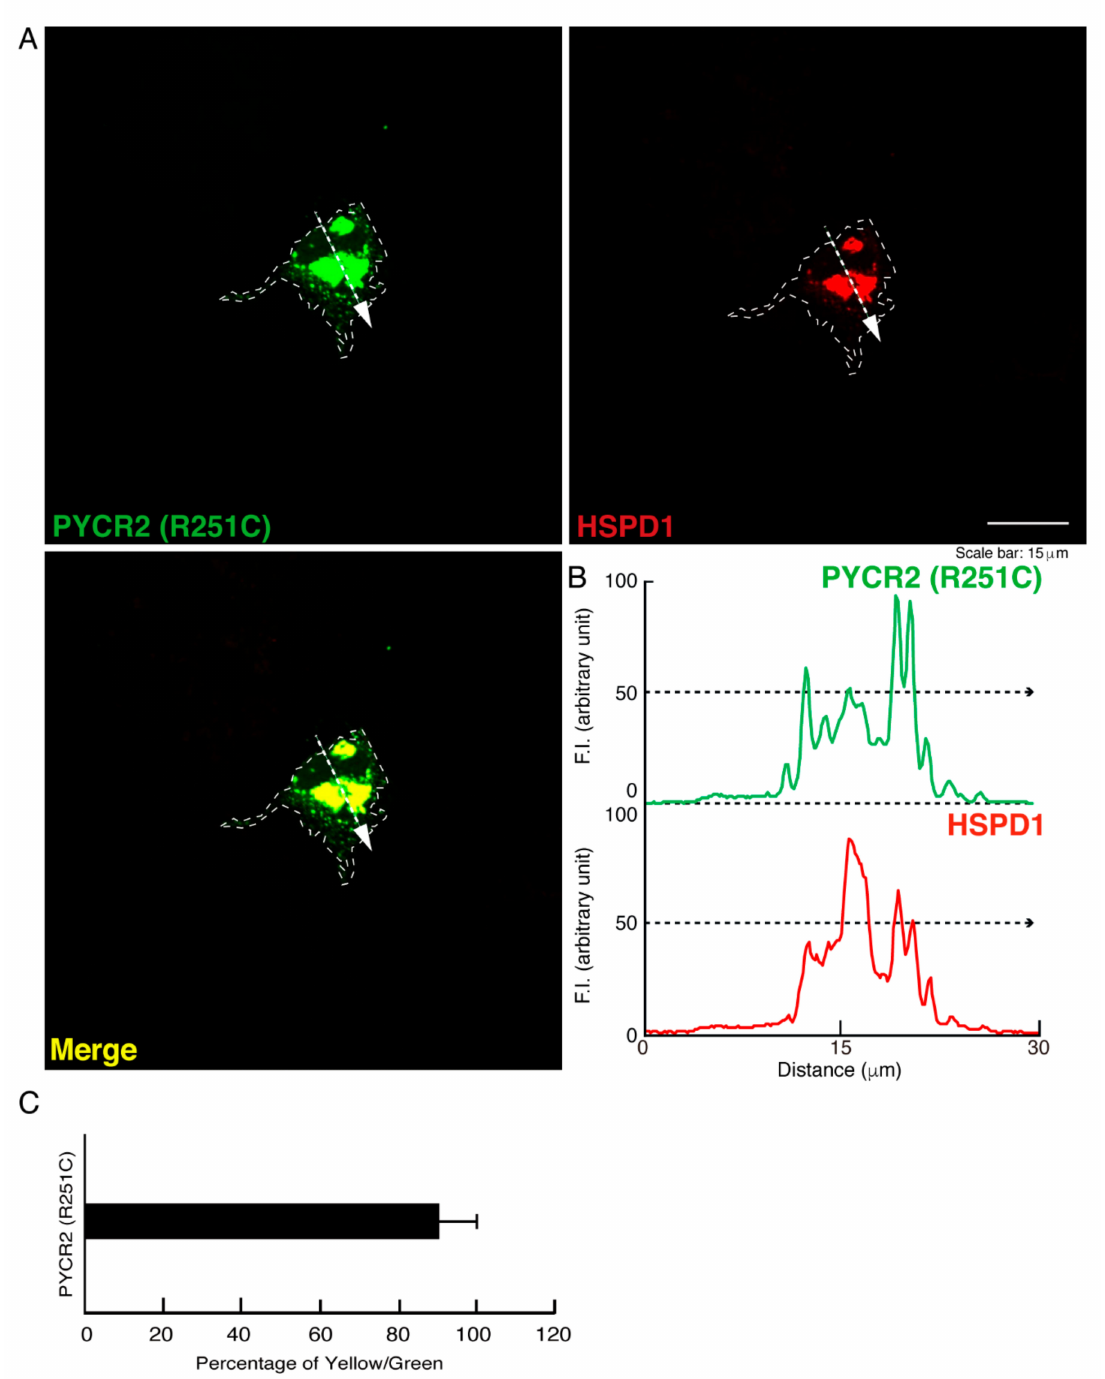
Figure 4. The R251C proteins are significantly co-localized with the large size mitochondria. ( A , B ) COS-7 cells were transfected with the plasmid encoding the GFP-tagged PYCR2 R251C and stained with an antibody against the mitochondrion-specific antigen HSPD1 (red). GFP-tagged PYCR2 R251C proteins were identified by their green fluorescence color. The approximate outline of the cell is surrounded by white dotted lines. Scan plots were performed along the white dotted lines in the direction of the arrows in the color images (green and red as well as merged images). Graphs showing the fluorescence intensities (F.I., arbitrary units) along the lines in the direction of the arrows were depicted in the right bottom panels. ( C ) Percentage of merged yellow fluorescence pixel values per green fluorescence ones are shown in the